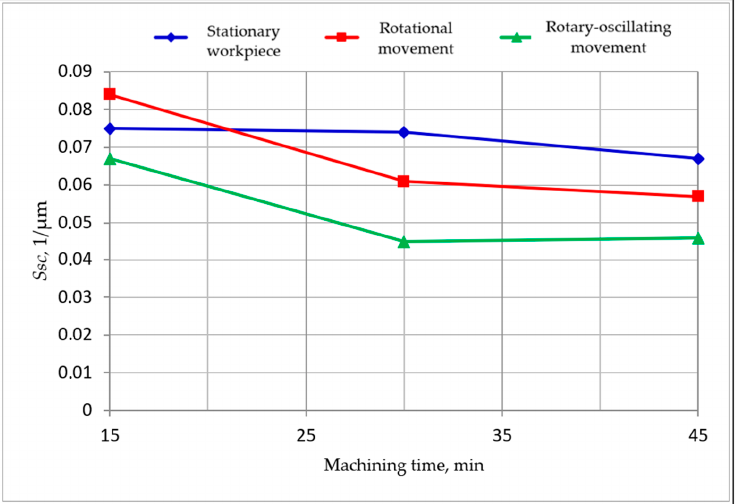
Figure 8. Changes of the arithmetic mean summit curvature Ssc as a function of machining time.